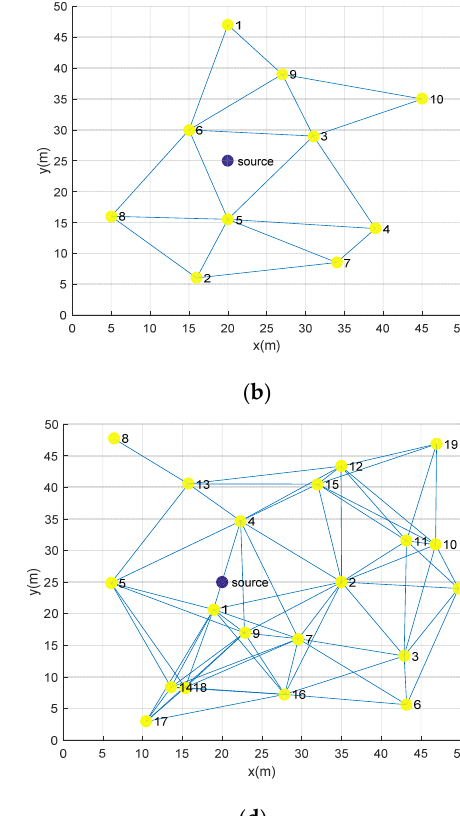
Figure 3. The topologies of four WASNs with different node numbers: ( a ) 5 nodes; ( b ) 10 nodes; ( c ) 15 nodes; ( d ) 20 nodes.